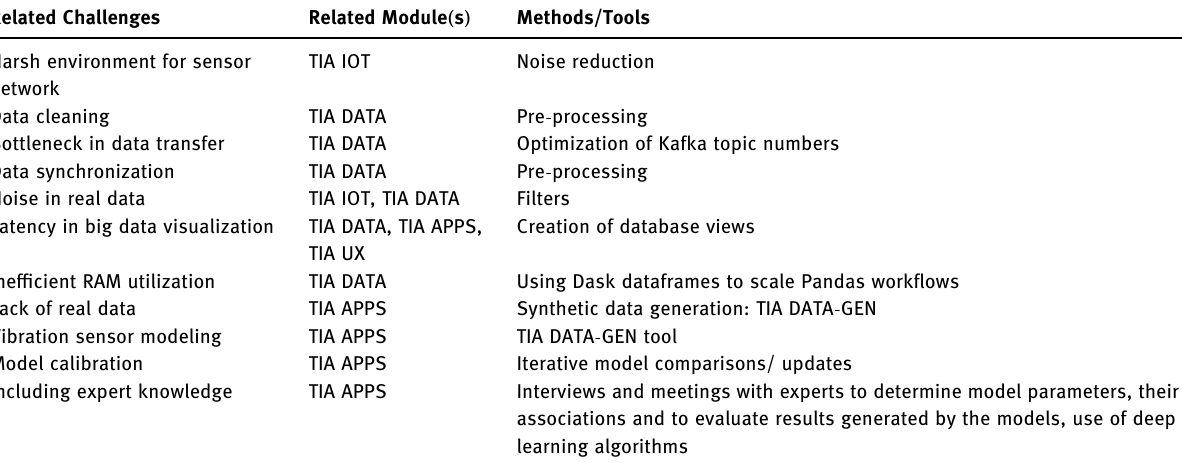
Table 2: Challenges and methods/Tools to solve them for DTs in the NOKSEL pilot Related